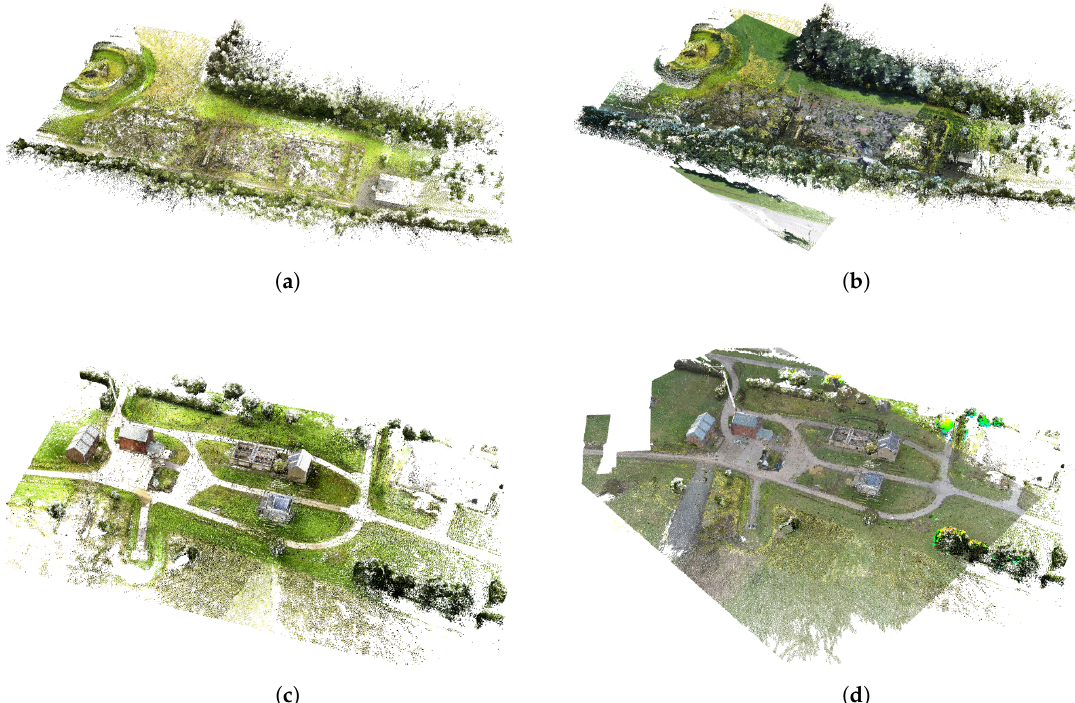
Figure 16. Comparison of the reference ground truth model (multi-colored) and resulting UGV-UAV datasets. ( a , b ) rubble field scenario and ( c , d ) village scenario. Dataset: Military-base Marche en Famenne,